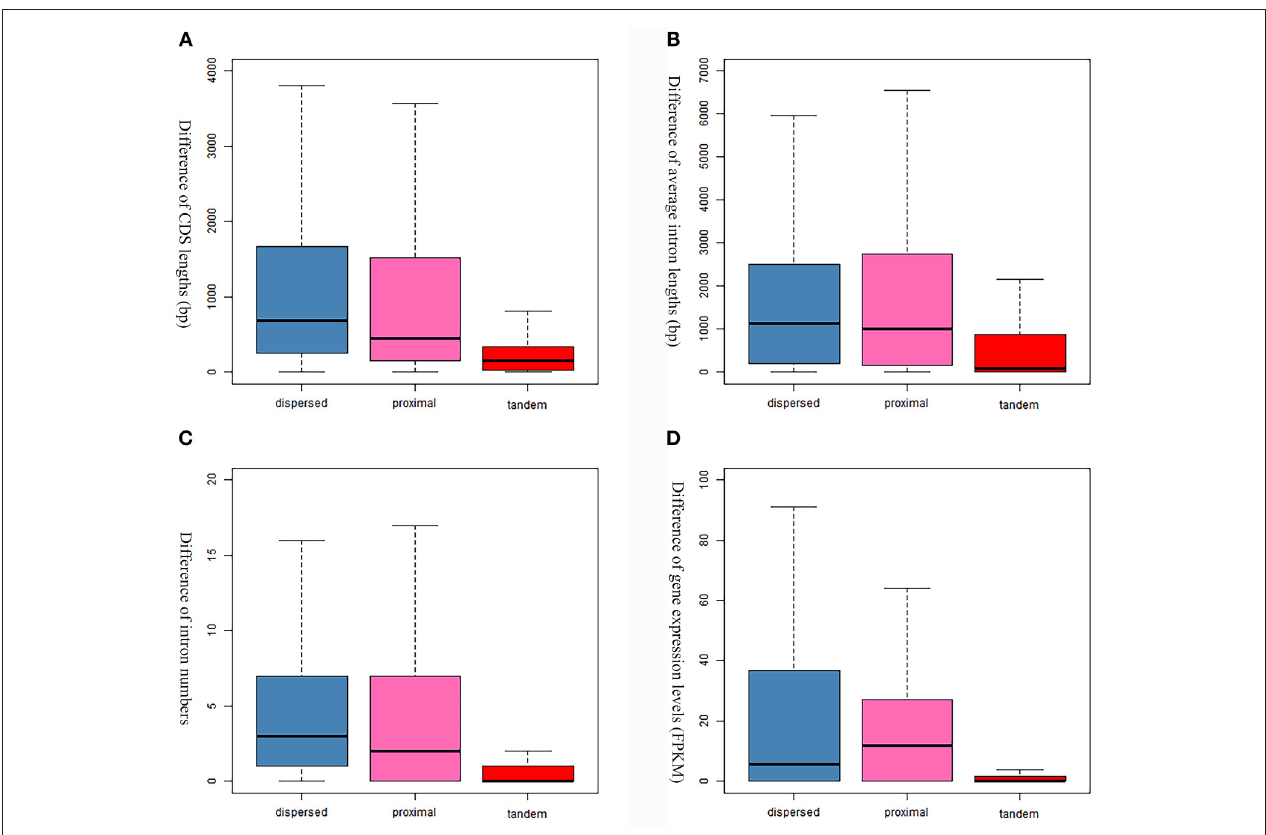
FIGURE 6 | Comparison of gene evolution following gene duplications. (A) Comparison of coding sequence lengths. (B) Comparison of average intron lengths. (C) Comparison of intron numbers. (D) Comparison of expression levels that are evaluated by FPKM